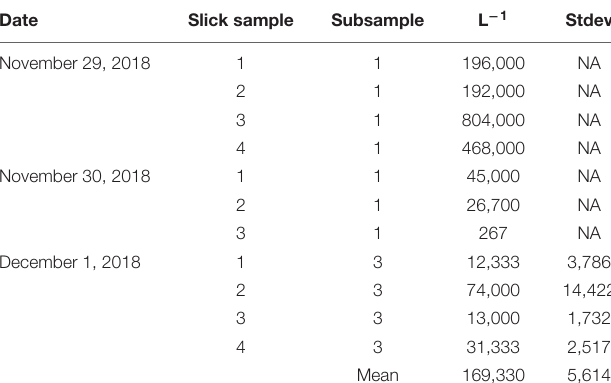
TABLE 3 | Concentrations of live coral embryos found in wild coral-spawn